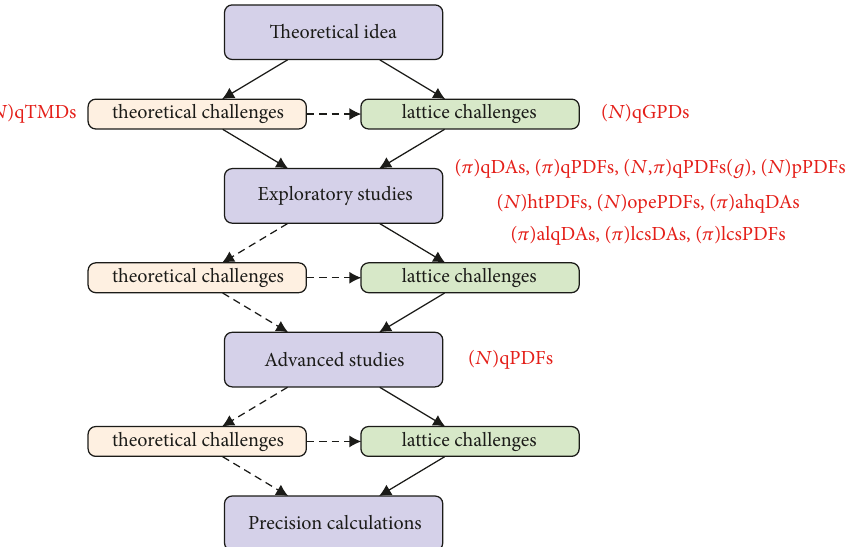
Figure 40: Flowchart of different methods of accessing partonic distributions considered in this review. Four main stages of every calculation are presented in blue boxes, connected with red/green boxes representing the theoretical and lattice challenges that need to be overcome to go to the next stage. Solid arrows indicate that given types of challenges emerge as a general rule, while dashed arrows signify that a given type of challenge does not have to appear for every method. The red text corresponds to different approaches and their current status. The symbol in parentheses indicates the hadron to which a given type of distribution pertains ( 𝑁 is nucleon and 𝜋 is pion (also other mesons in certain cases)). The considered distributions are PDFs/DAs/GPDs/TMDs, in general for quarks (with an explicit counterexample of gluonic PDFs indicated with parentheses at the end ( 𝑔 )). The approach is indicated with small letters before the distribution name: q is quasidistributions, p is pseudodistributions, ht is hadronic tensor, ope is OPE without OPE, ahq is auxiliary heavy quark, alq is auxiliary light quark, and lcs is good lattice cross-sections. Example: (𝑁) qPDFs: quark PDFs of the nucleon accessed with the quasidistribution